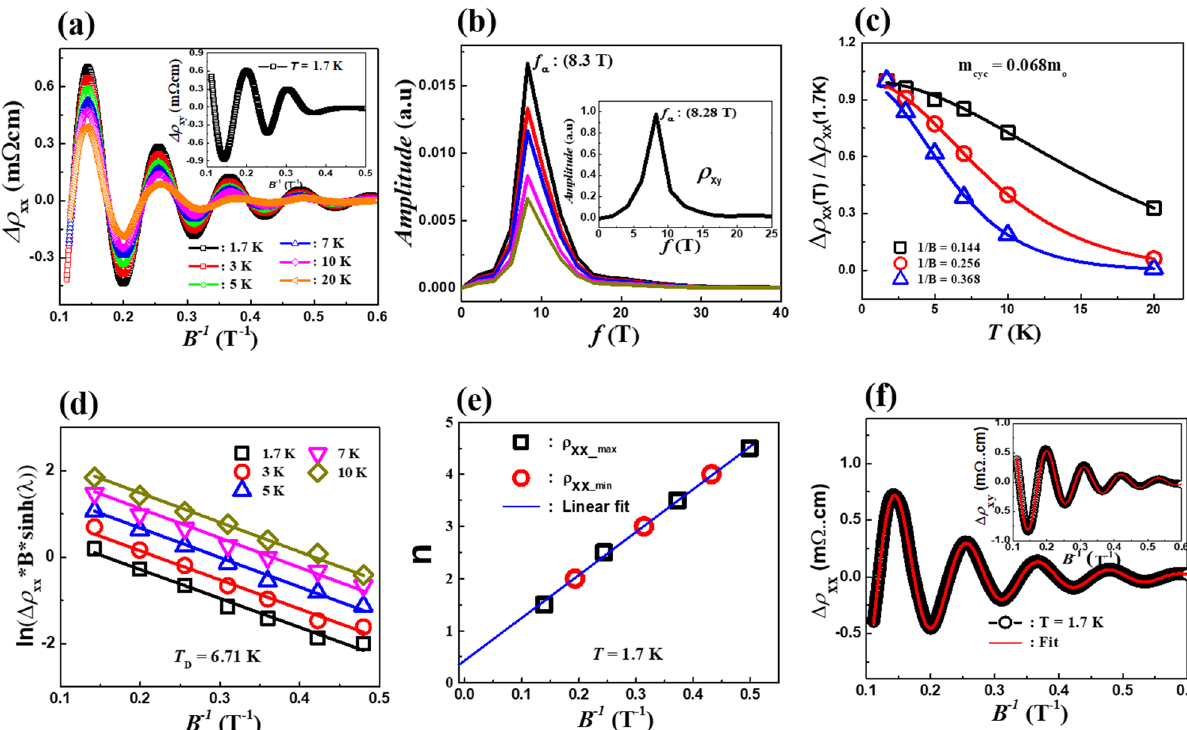
Figure 2. ( a ) Shubnikov-de Haas (SdH) oscillations in the transverse magnetoresistance of a Bi 0.97 Sb 0.03 single crystal at different temperatures. Insets of ( a ) show the SdH oscillations in the Hall resistivity of a Bi 0.97 Sb 0.03 single crystal at T = 1.7 K. ( b ) Fast Fourier transform (FFT) of the SdH oscillations in �ρ xx ( B ) at different temperatures shows a single oscillation frequency. Inset of ( b ) shows FFT of the SdH oscillations in �ρ xy ( B ) at T = 1.7 K. ( c ) The amplitudes of the SdH oscillations are shown as a function of temperature. A comparison is made between these amplitudes and the Lifshitz-Kosevich equation. ( d ) The amplitude of SdH oscillation versus the inverse magnetic field is plotted to estimate the Dingle equation. ( e ) A Landau fan diagram is constructed from the maximum and minimum of the SdH oscillations. ( f ) The direct fitting of SdH oscillations from the